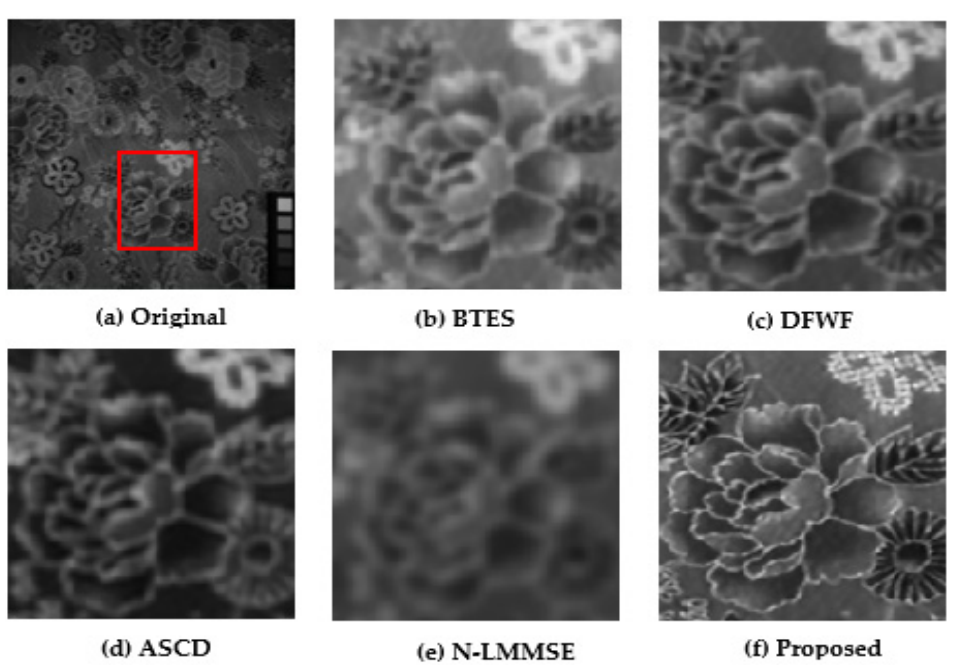
Figure 14. Visual comparison of red band in cloth image.